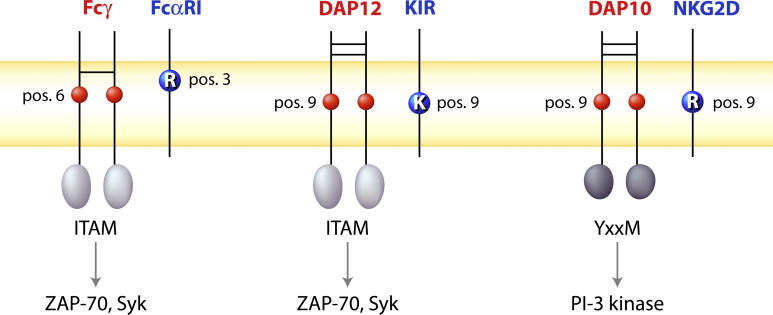
Many activating receptors in the immune system assemble with their dimeric signaling modules in the membrane through an interaction between their basic transmembrane residue and a pair of acidic transmembrane residues of the signaling module.